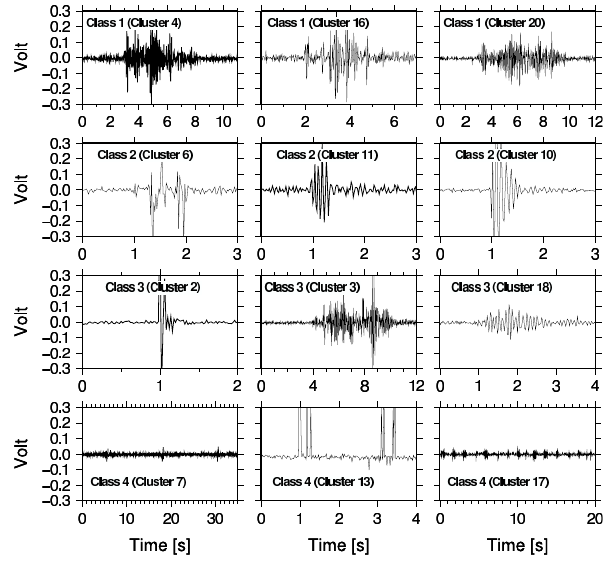
Fig. 5. Randomly selected examples of all event classes. Class 1: clear calving-related seismic events, Class 2: most likely glacier events, Class 3: maybe glacier events, Class 4: no glacier events. Same amplitude scale for all